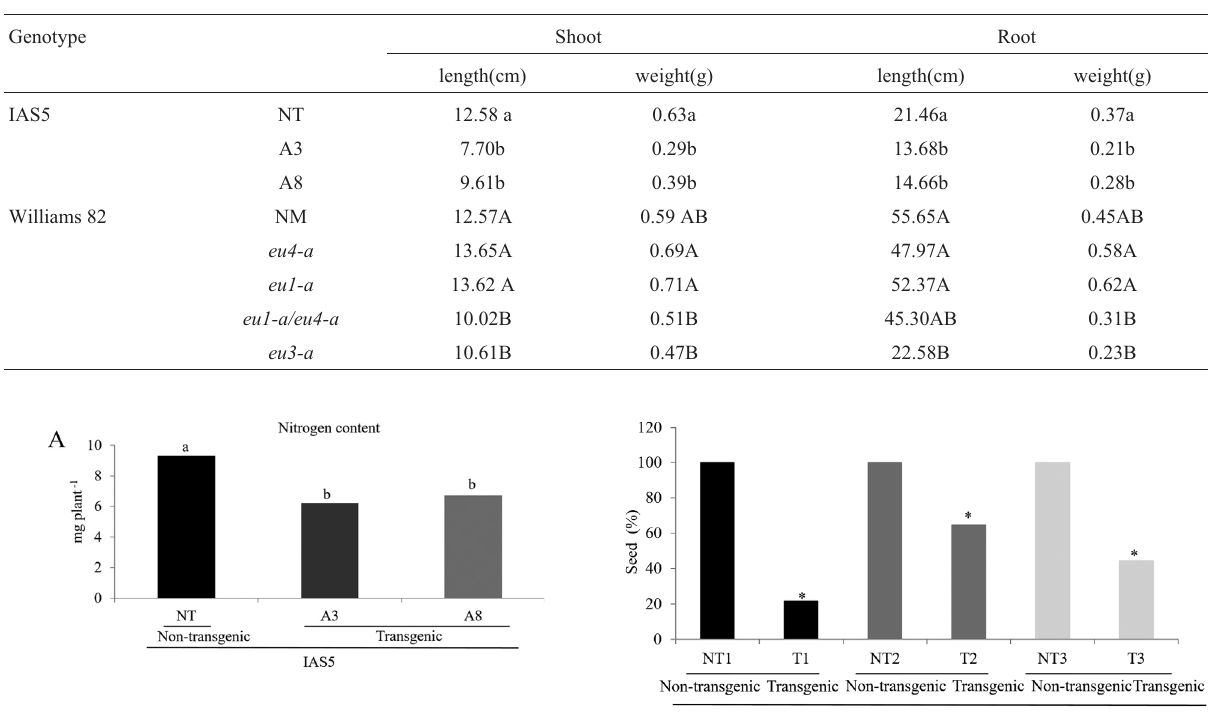
Table 2 - Dry matter and length of roots and shoots one month after germination.